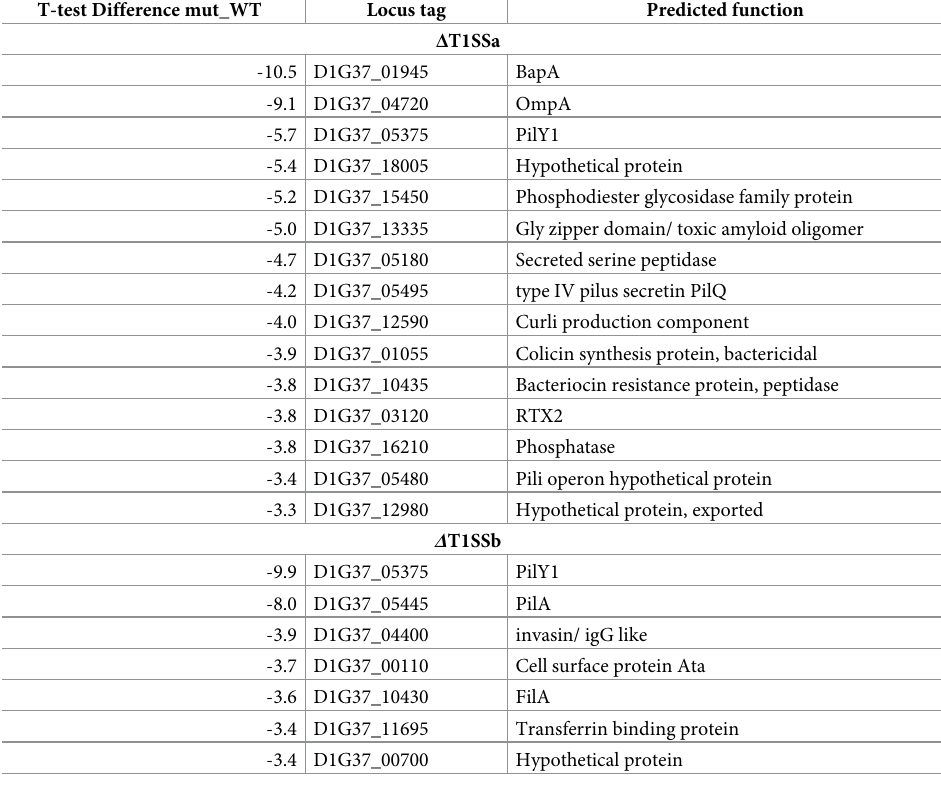
Cut-off was defined at -3 by a student T-test difference between mutant and WT. Protein localization prediction was performed employing PSORT and presence of a signal peptide was analyzed by